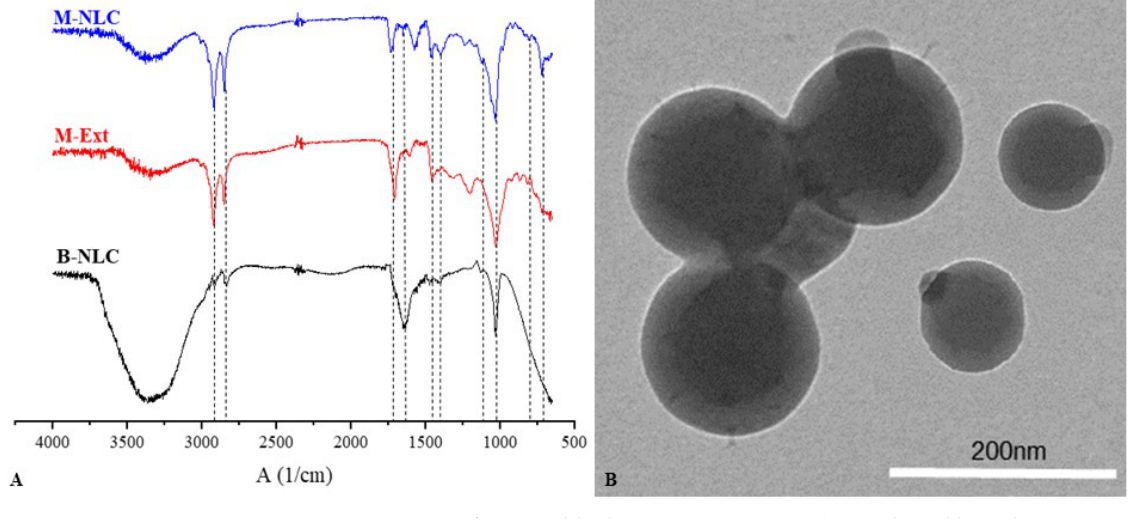
Figure 6. FTIR spectra of B-NLC; blank NLCs, M-Ext; M. indica peels and kernel extract, M-NLC; M- Ext loaded NLCs ( A ), TEM image of M-NLC ( B ).